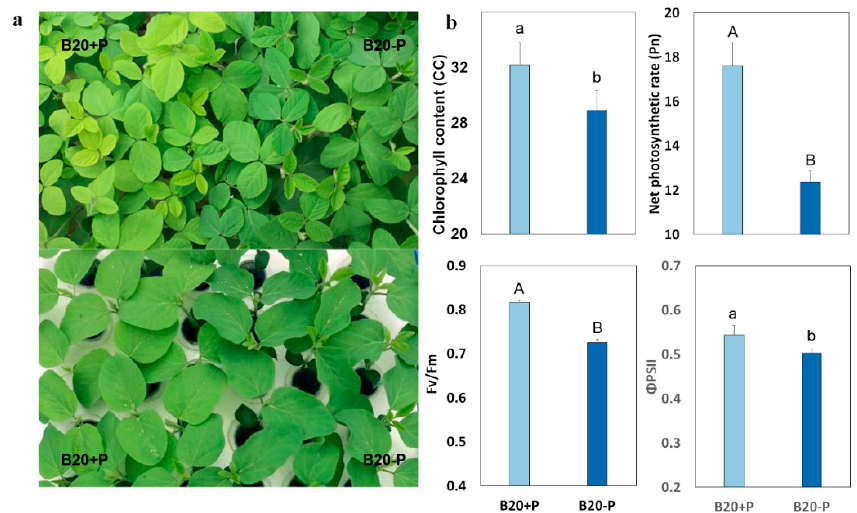
Figure 1. Effects of low-P stress on morphology and photosynthetic parameters of soybean seedling. Five days old germinated plants were transferred on Hogland nutrient solution (Optimum P, +P, 1000 μ mol KH 2 PO 4 ; Low-P, − P, 5 μ mol KH 2 PO 4 ) and allowed to grow for two weeks under hydroponic conditions. ( a ) Soybean grown under optimum P conditions (left) and − P conditions (right); ( b ) The effects of low-P stress on soybean photosynthetic parameters chlorophyll content (CC), net photosynthetic rate (Pn), maximum quantum efficiency of PSII (Fv/Fm) and quantum efficiency of PSII ( Φ PSII). ANOVA was used to compare significance and the lowercase/capital letter denote significantly different at p < 0.05/0.01 (Least Significant Difference, LSD test). Table 1. Phenotypic variation of photosynthetic- and P efficiency-related traits in soybean. Traits Name (Units)